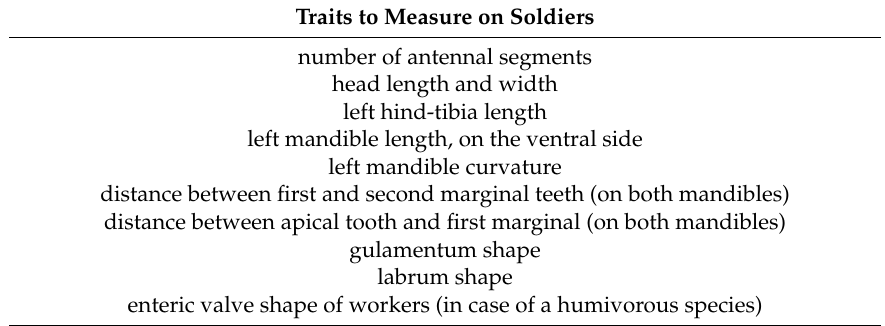
Table 3. List of minimum morphometric traits to measure on an imago for species description. Traits to Measure on Imagoes head width lesser and larger diameters of eyes and of ocelli fontanelle shape left hind-tibia